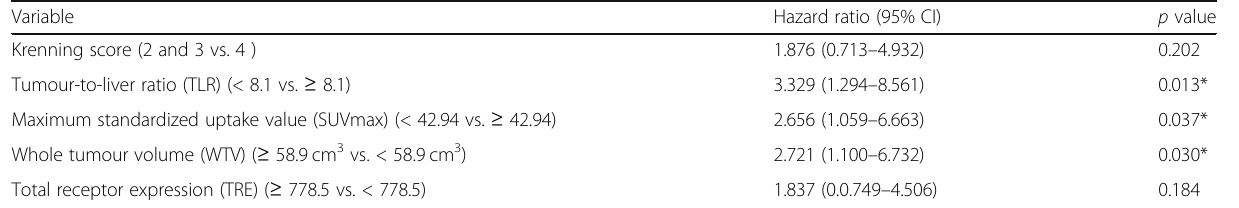
Table 4 Univariate analysis of [ 68 Ga]Ga-DOTA-TOC PET/CT variables for PFS after lanreotide therapy Variable